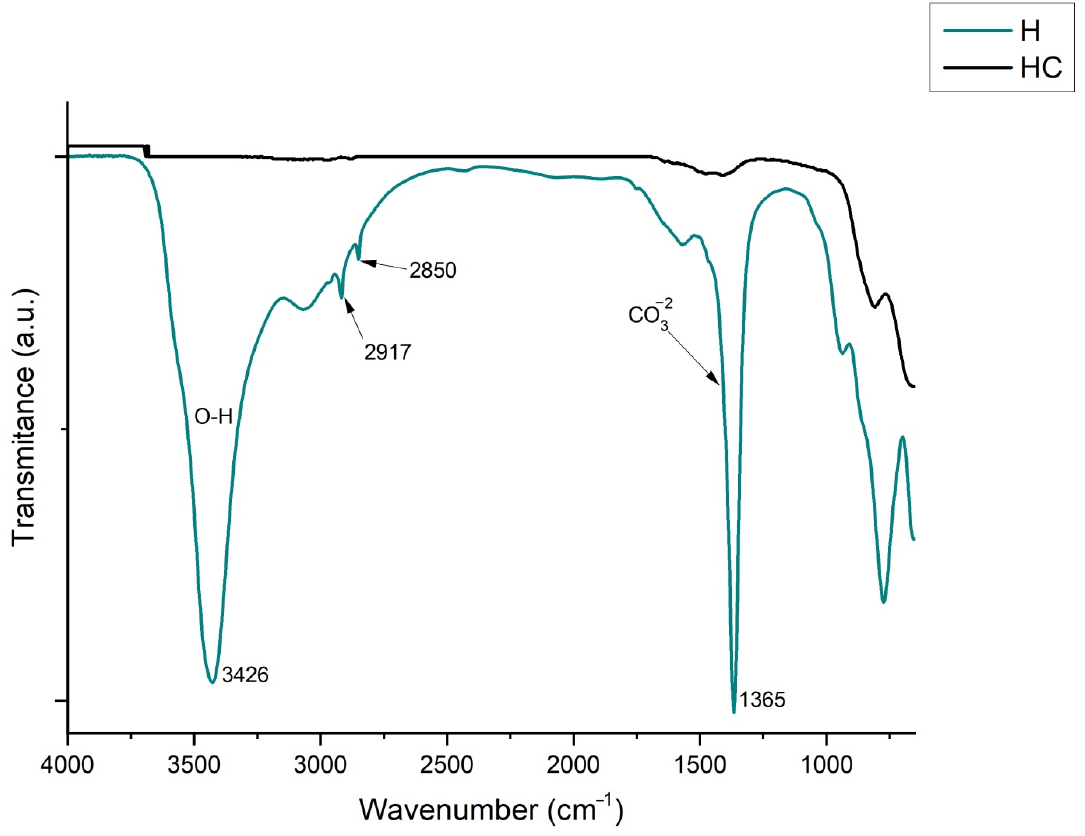
Figure 12. FTIR of uncalcined hydrotalcite (H) and calcined hydrotalcite (HC).